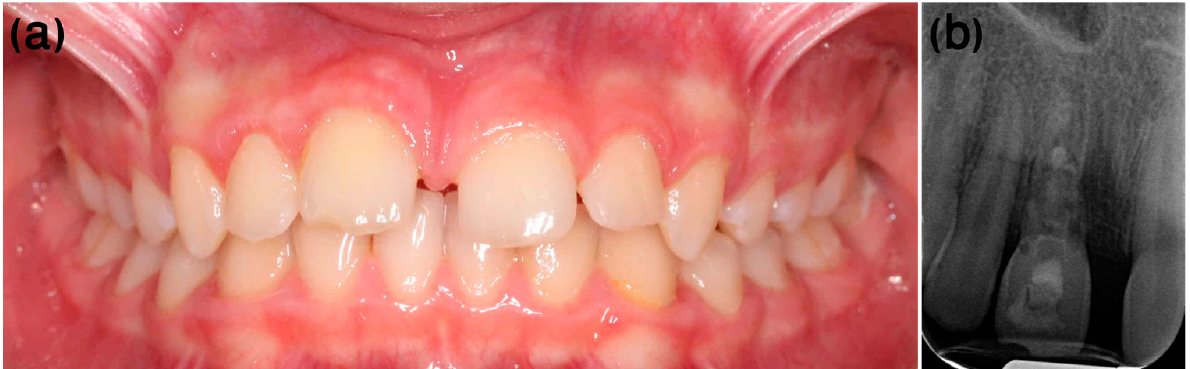
Figure 11. Case 2, one-year follow-up. ( a ) One year after the trauma, infra-occlusion of 2 mm was evident. ( b ) Marked replacement resorption was noted on the X-ray.